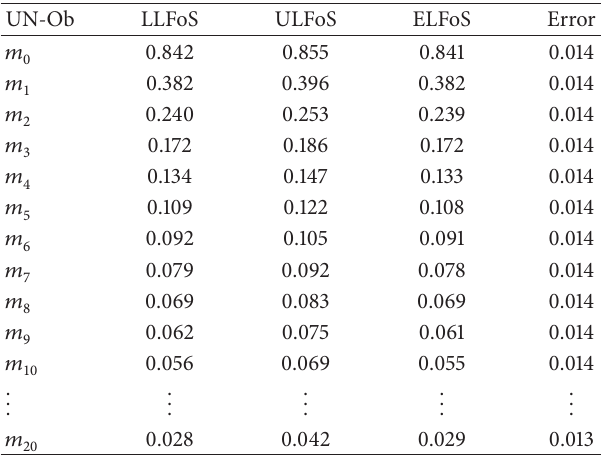
Table 1: Upper and lower bounds for Example 1 for 𝑁 = 28